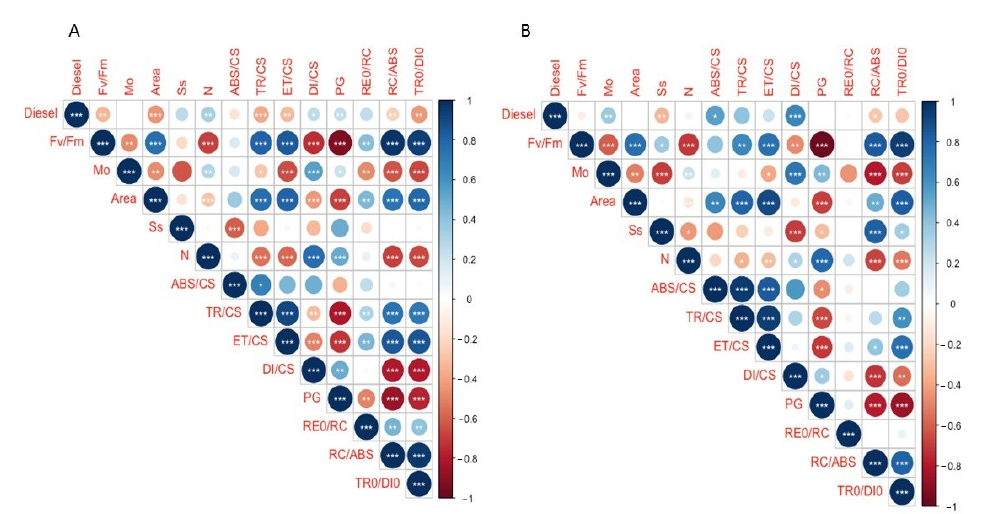
Figure 8. Spearman correlations coefficients (r 2 ) between the evaluated photochemical variables and the diesel concentrations applied in plants grown without ( A ) and with ( B ) NaCl supplementation.